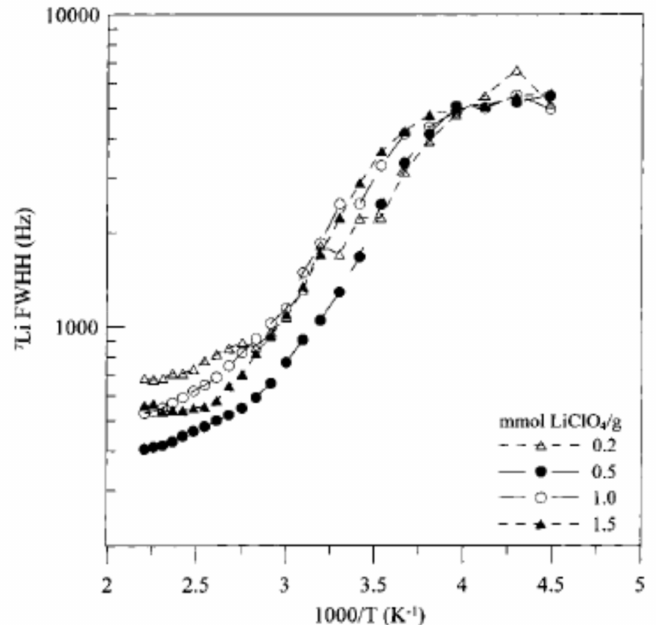
Figure 11. Arrhenius plot based on full width at half maximum (FWHM) measurement from a series of PEO-polydimethylsiloxane (PDMS) films doped with varying amounts of LiClO 4 . Reprinted with permission from [76]. Copyright 2002 American Chemical